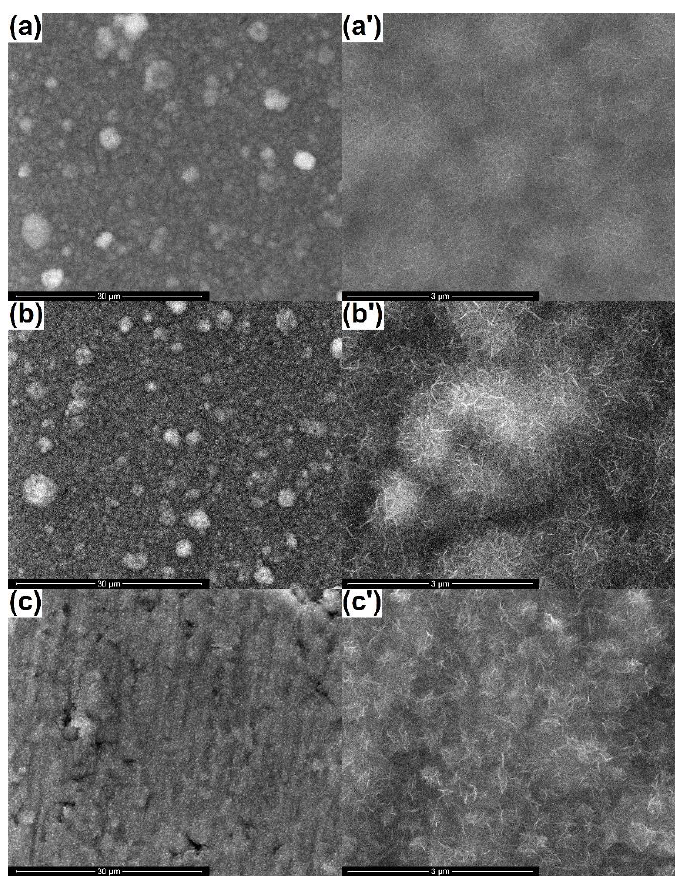
Figure 3. SEM images of the deposited thin films after SBF immersion for 28 days: ( a and a' ) PLD-RT, ( b and b' ) PLD-300 and ( c and c' ) SC-Ti.